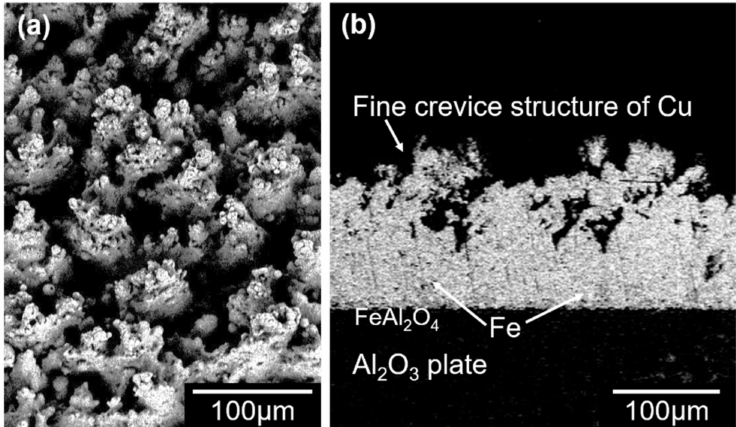
Figure 7. ( a ) Surface and ( b ) cross-section of laser-irradiated surface fine crevice structure of metallic copper created on the surface of copper (iron contained or dissolved)-metallized Al 2 O 3